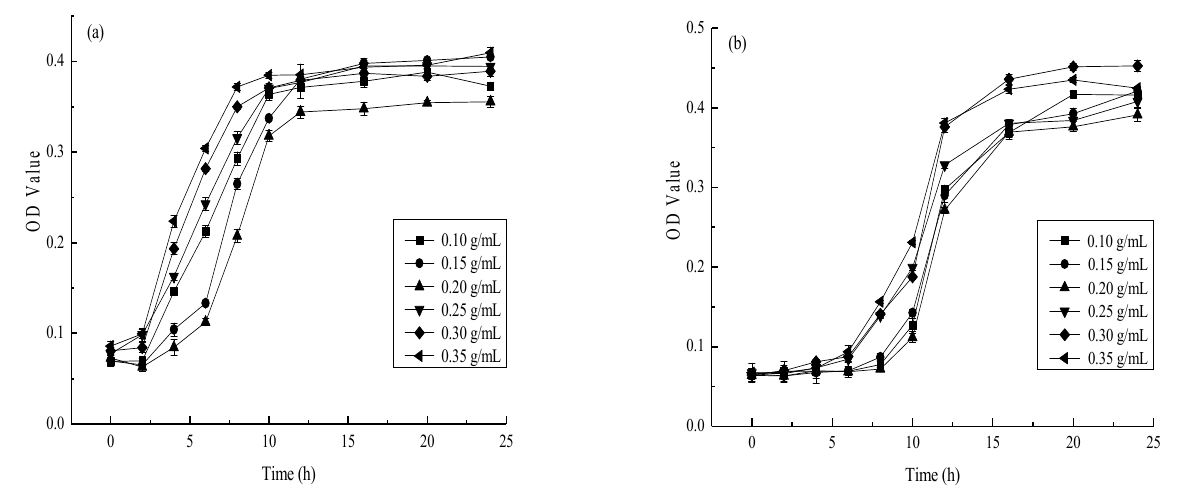
Figure 3. Effects of different silver nanoparticles on the antibacterial activity of S. aureus (( a ) Nanosilver sol concentration is 20% nanosilver sol stock solution, ( b ) Nanosilver sol concentration is 40% nanosilver sol stock solution).